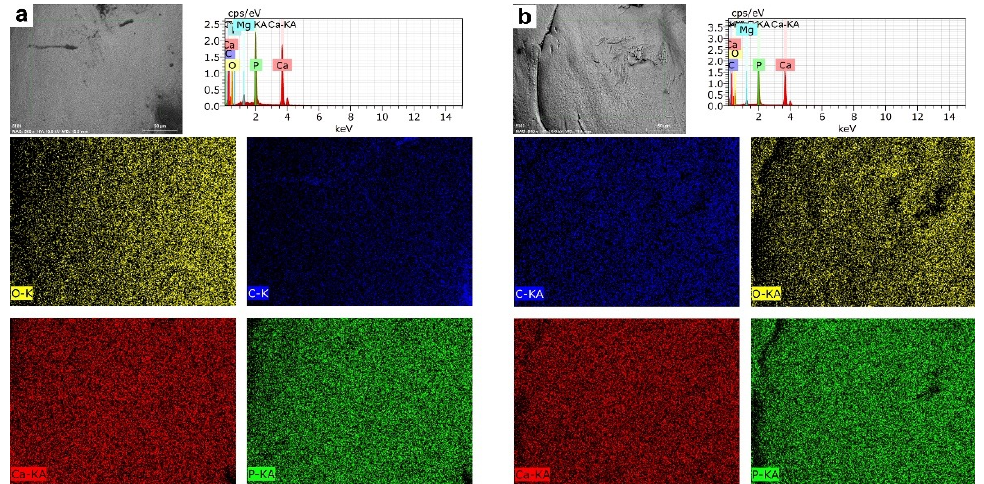
Figure 4. Mapping Elemental Distribution in teeth of rainbow trout (Oncorhynchus mykiss). ( a ) Farmed fish. ( b ) Wild fish. BSD image, 500× magnification. Scanning Electron Microscope (Hitachi SU3500, Tokyo, Japan) coupled to XFlash ® Detector 410 and Quantax Esprit 1.8.1 Software controller (Bruker, Germany).